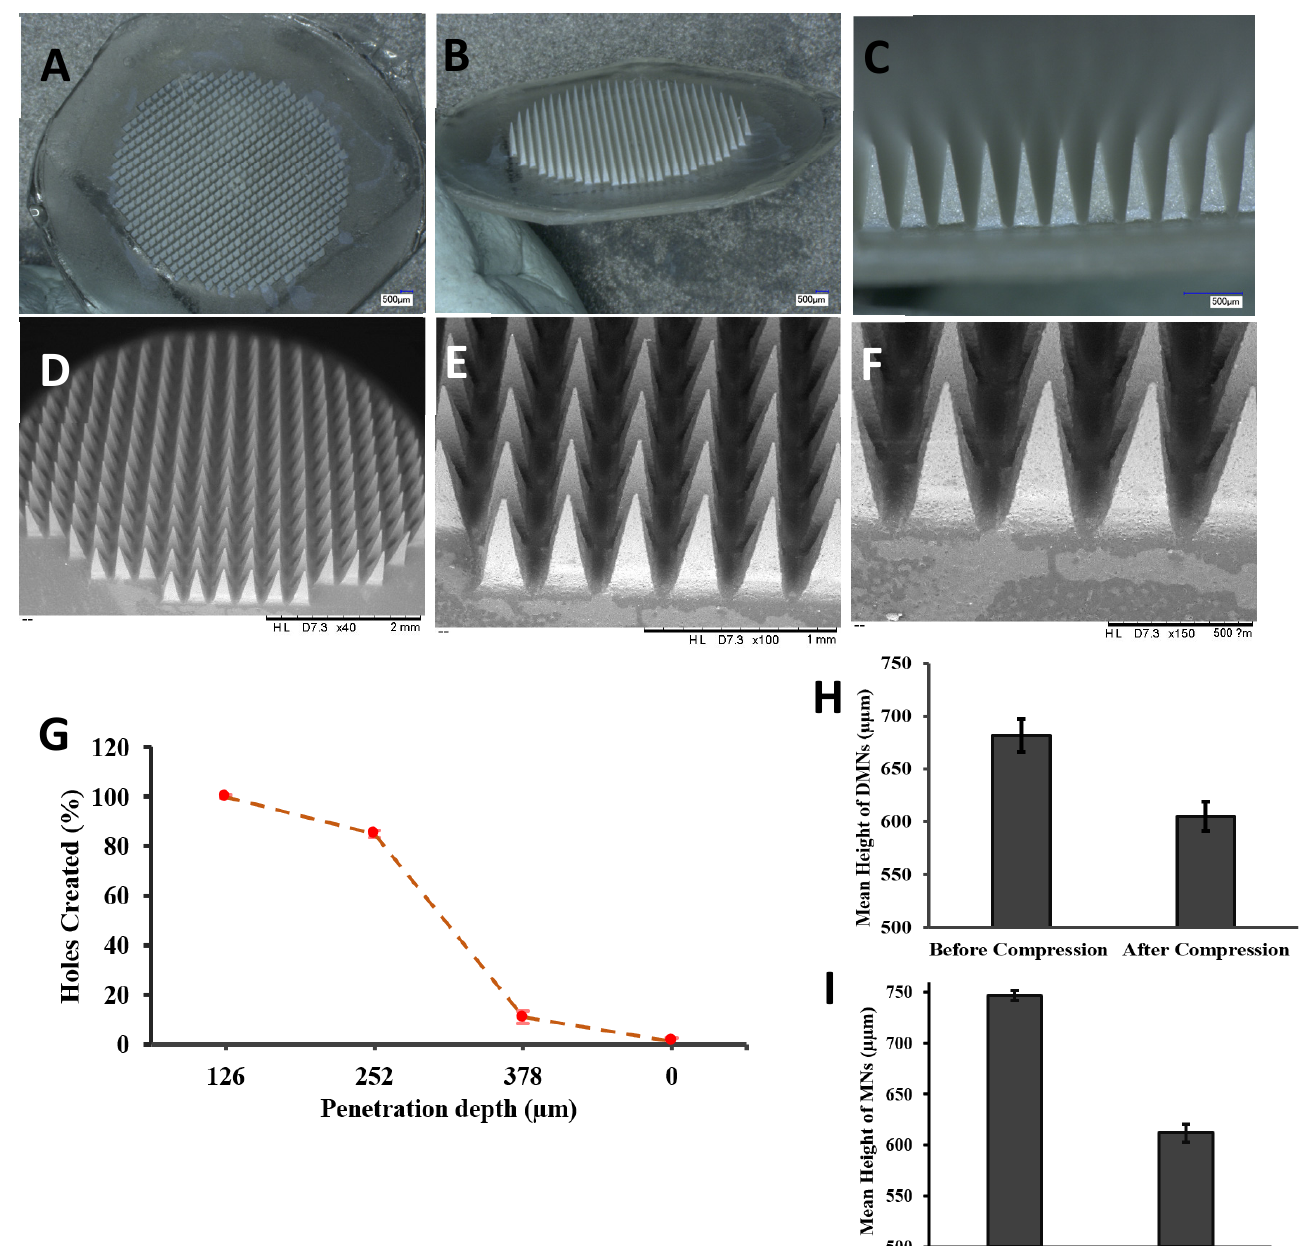
Figure 4. ( A – C ) Digital images of DFS ‐ NS ‐ DMNs at different magnifications. ( D – F ) SEM images of DFS ‐ NS ‐ DMNs. ( G ) The percentage of holes created in Parafilm M ® layers and the corresponding approximate insertion depth. Mechanical strength determination of DMNs by a texture analyzer by applying a force of 32 N for 30 s (mean ± SD, n = 6). ( H ) Mean height reduction of DFS ‐ NS ‐ DMNs, ( I ) Mean height reduction of DFS ‐ DMNs.